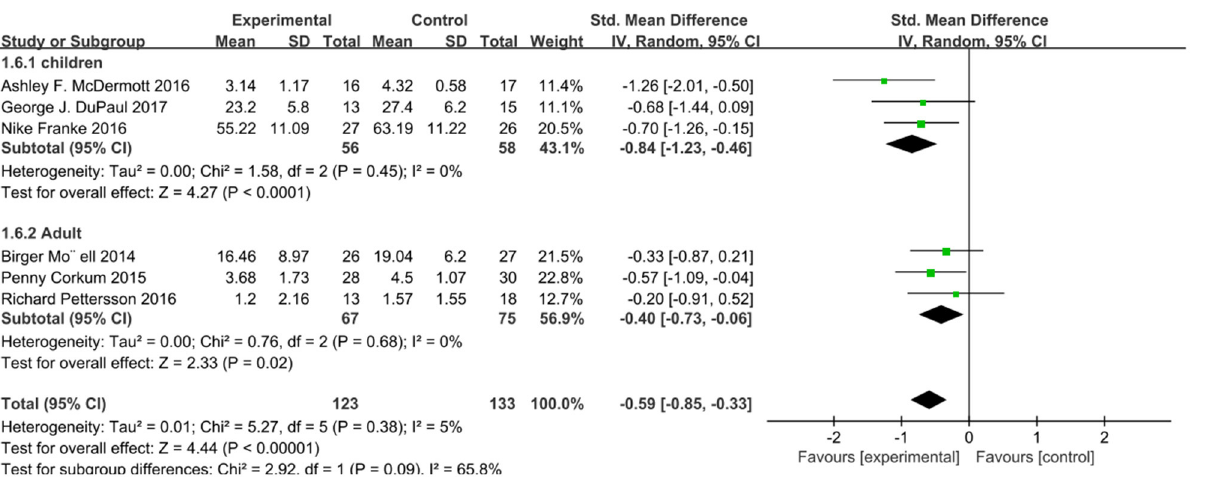
FIGURE 7 | Subgroup analysis of social function score of online intervention ADHD compared with waiting list (for children or